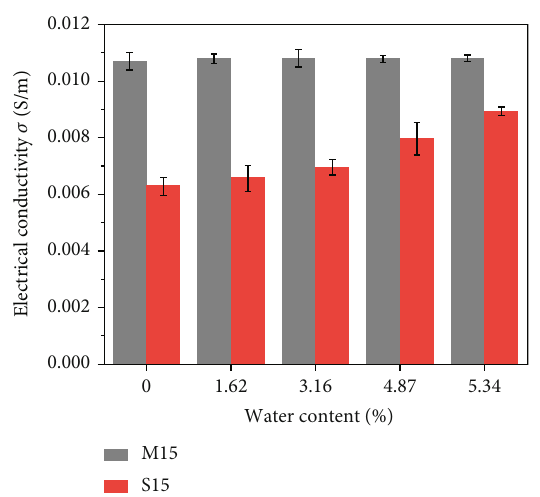
Figure 5: Di ff erential curve of pore size distribution of mortar specimen.